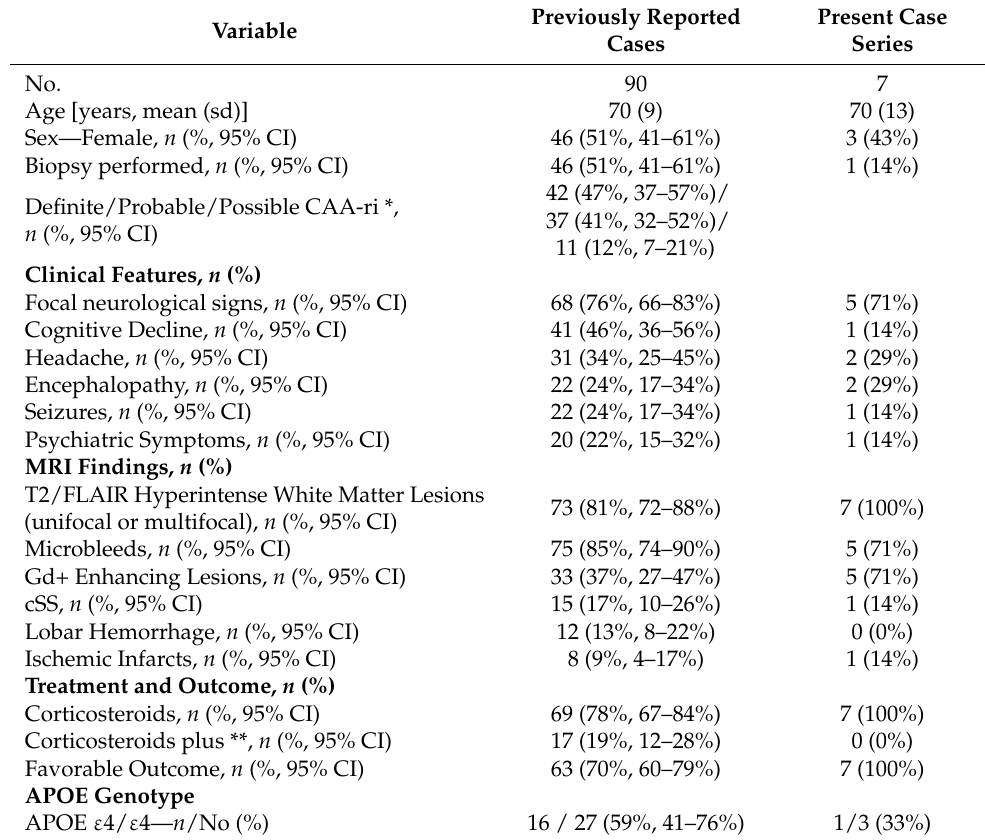
Table 2. Summary of the characteristics of the reported case reports and small case series with Cerebral Amyloid Angiopathy–related inflammation. Previously Reported Present Case Variable Cases